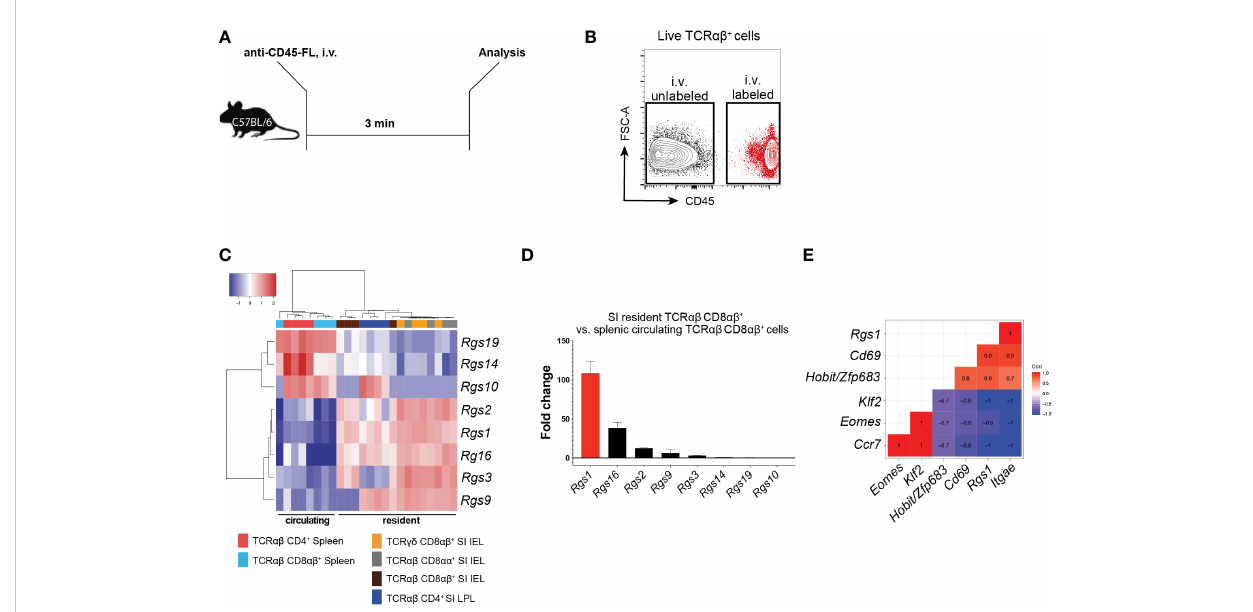
FIGURE 1 Expression of Rgs gene family members in small intestinal resident T cell subsets versus circulating splenic cell subsets (A) Experimental set-up. C57BL/6JRj mice were injected i.v. with a fl uorophore (FL)-conjugated anti-CD45 mAb 3 min before euthanasia. (B) Representative FACS plot showing the isolation strategy for i.v. labeled, circulating vs . i.v. unlabeled, resident T cells. (C) Heat map of the Rgs gene expression pro fi le of circulating and resident T cell subsets (all data points are from FACS-sorted cells pooled from 1 to 5 animals. Analyses were repeated at least 3 times with comparable results). (D) Fold change in the expression of Rgs gene members in small intestinal TCR ab CD8 ab + IEL vs . splenic TCR ab CD8 ab + T cells (all data points represent cells pooled from 1 to 5 animals). Analyses were repeated at least 3 times with comparable results, mean ± SEM. (E) Pearson correlation of Rgs1 expression and signature genes predominantly expressed by the resident (i.e. Itgae , Cd69 , Zfp683/Hobit ) vs . circulating (i.e. Klf2 , Eomes , Ccr7 ) memory TCR ab CD8 ab + T cells (n=8, all data points represent cells pooled from 1 to 5 animals. Analyses were repeated at least 3 times with comparable